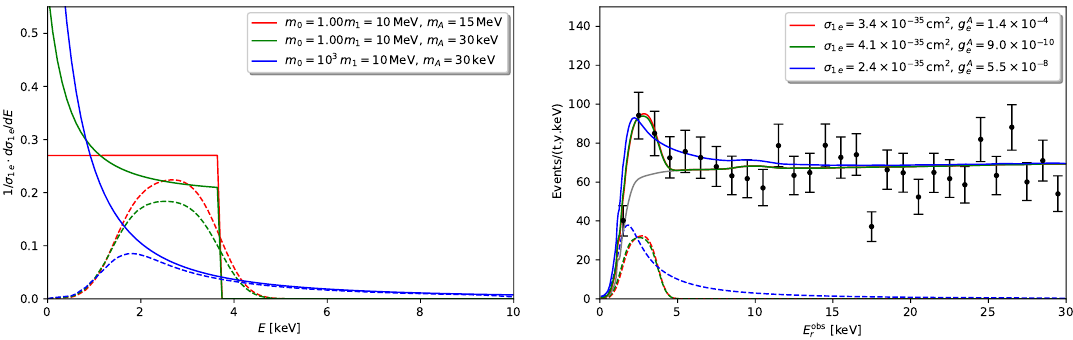
Figure 4 . [Left] The corresponding unit-normalized plots with the same benchmark mass spectra as in figure 2 but with the axial-vector mediator and fermionic BDM (i.e., the AF case). The solid ( E ) and the dashed ( E obs ) lines are the spectra without and with detector effects, respectively. r r [Right] Sample energy spectra for the three benchmark mass spectra. We assume g A galactic BDM for which the flux is given by eq. (3.2). The values of σ these fits are shown in the